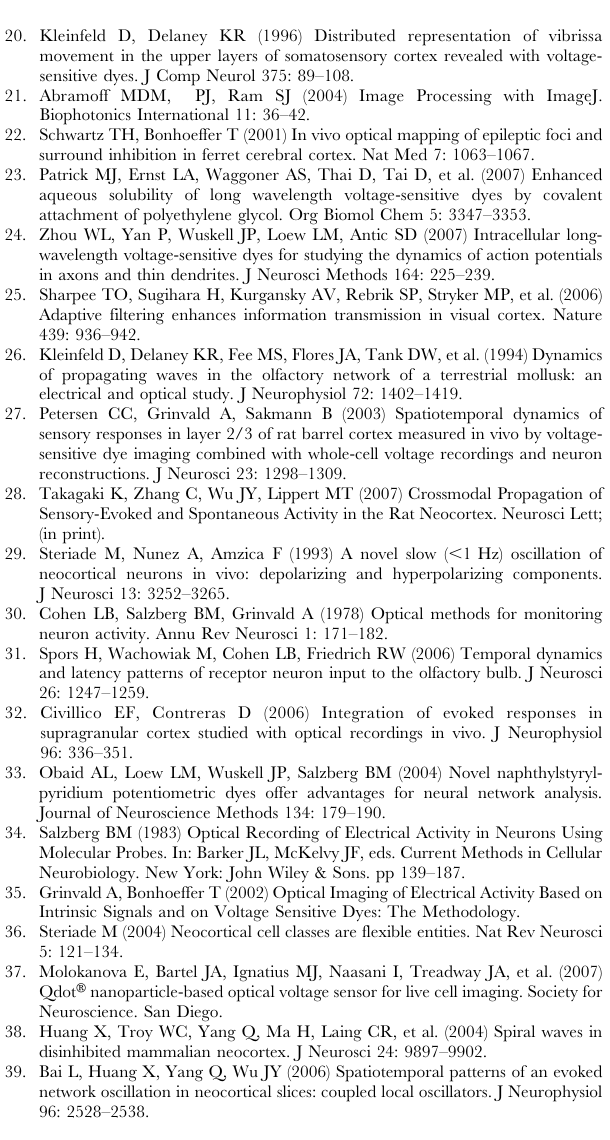
Figure S1 Electrical stability of epileptiform spikes and sleep-like slow waves. A,B. Epileptiform spike electrocorticograms recorded at an early point in the experiment (A) and 2 hours later (B). The amplitude and waveforms of the spikes can be maintained